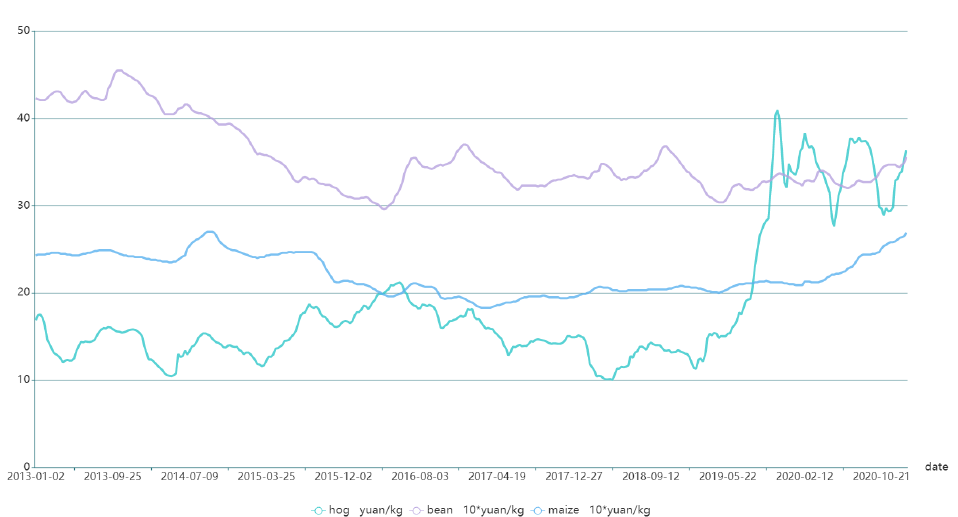
Figure 4. Weekly prices of the three agricultural products from 2013 to 2020.